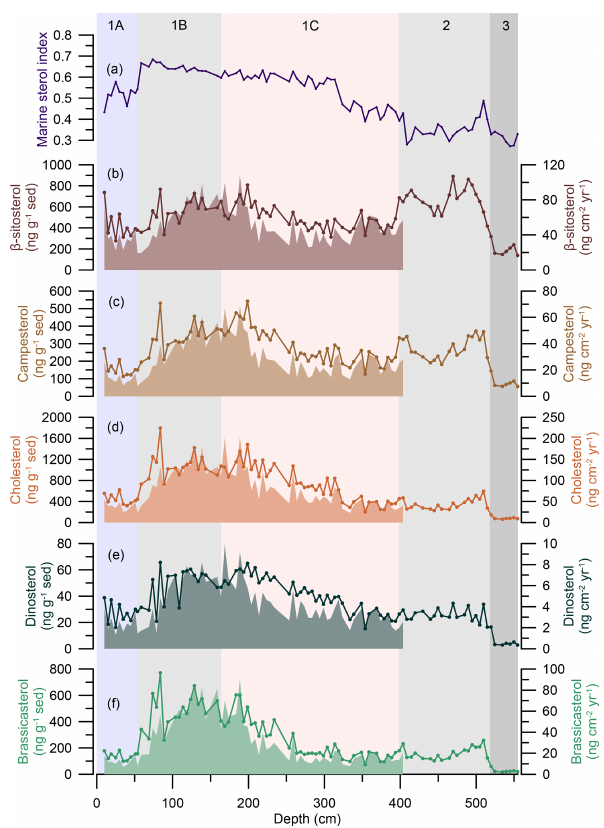
Figure 4. Sterol biomarker results at OD1507-03TC-41GC-03PC. From the top to the bottom: (a) marine sterol index (sum of marine sterols divided by the sum of all sterols) (purple line). (b) β -Sitosterol fluxes (brown, filled-in area) and absolute con- centration (brown line with dots) normalized to the amount of ex- tracted sediment (ngg − 1 sed). (c) Campesterol fluxes (light brown, filled-in area) and absolute concentration (light brown line with dots) normalized to the amount of extracted sediment (ngg − 1 sed). (d) Cholesterol fluxes (orange-brown filled-in area) and absolute concentration (orange-brown line with dots) normalized to the amount of extracted sediment (ngg − 1 sed). (e) Dinosterol fluxes (dark green, filled-in area) and absolute concentration (dark green line with dots) normalized to the amount of extracted sediment (ngg − 1 sed). (f) Brassicasterol fluxes (light green, filled-in area) and absolute concentration (light green line with dots) normalized to the amount of extracted sediment (ngg − 1 sed). Fluxes do not extend beyond ∼ 400cm, as this depth corresponds to the lower- most radiocarbon date (Reilly et al., 2019). The vertical background fill indicates the lithological units (1A–C, 2, 3) at OD1507-03TC- 41GC-03PC (Reilly et al.,